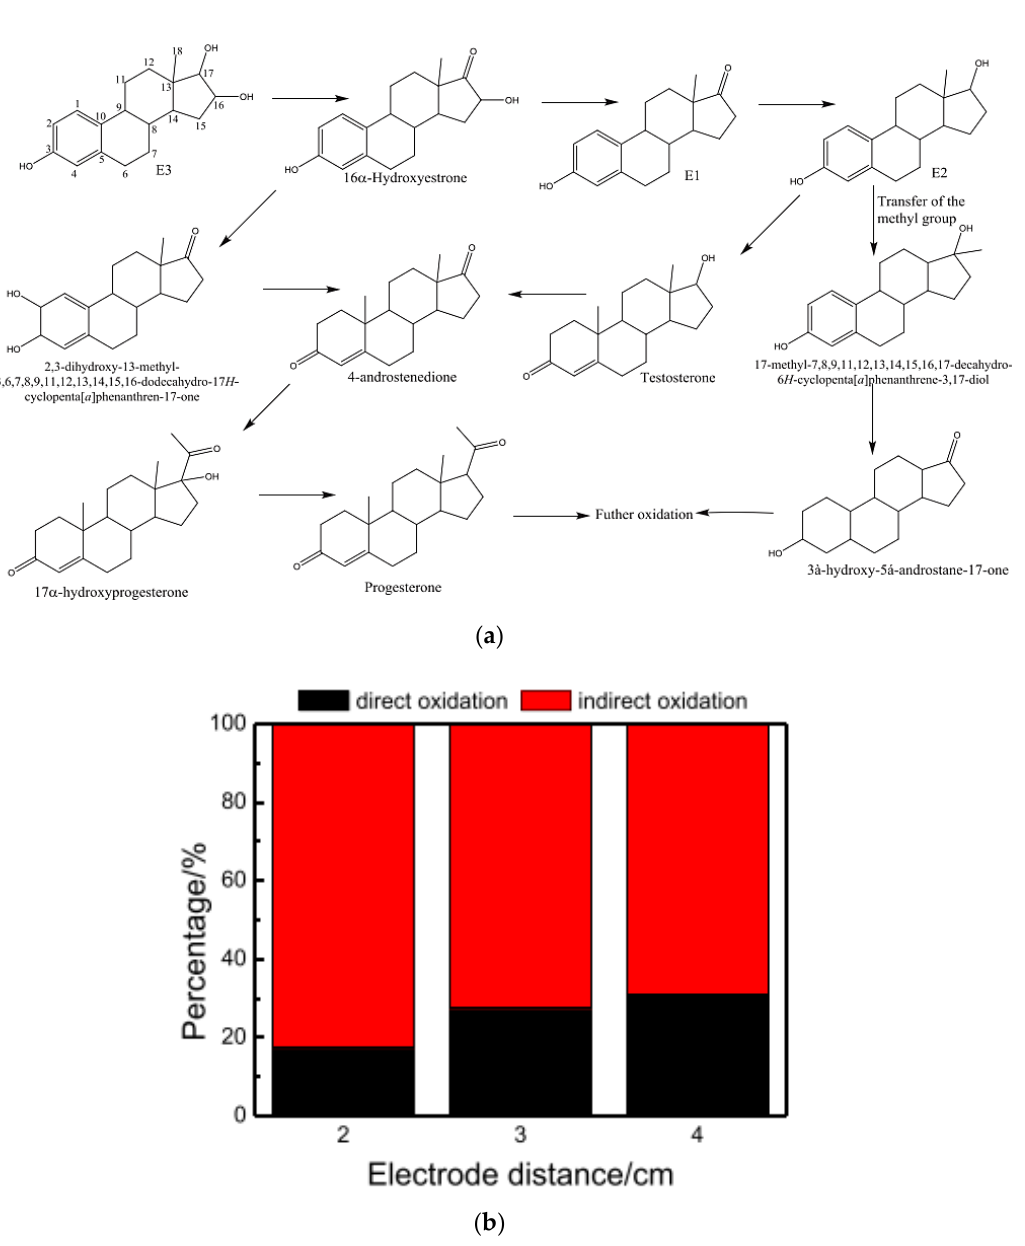
Figure 5. Proposed simplified pathways for estriol (E3) degradation in batch 3D electrolysis ( a ) and ( b ) the contribution of direct and indirect oxidation at various distances under operating conditions: C 0 = approximately 1000 µ g / L, j = 2.2 mAcm − 2 , constant current, Q = 150 mL / min. Reprinted from Shen et al. [69], copyright © (2017), with permission from